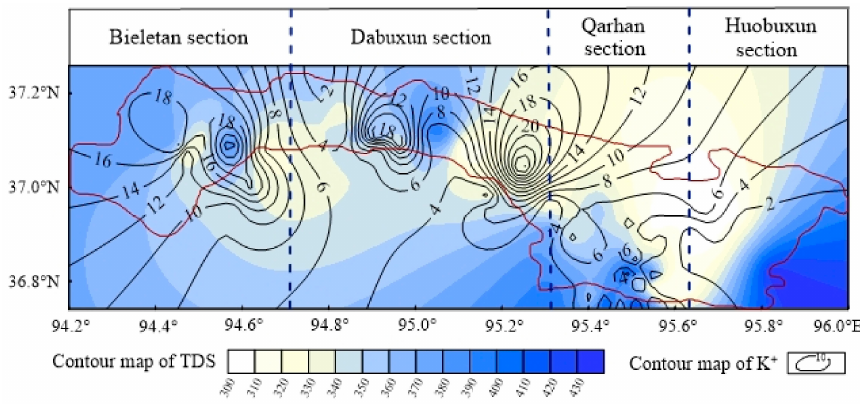
Figure 6. Contour map of K + (g / L) and TDS (g / L) of the intercrystalline brines in the